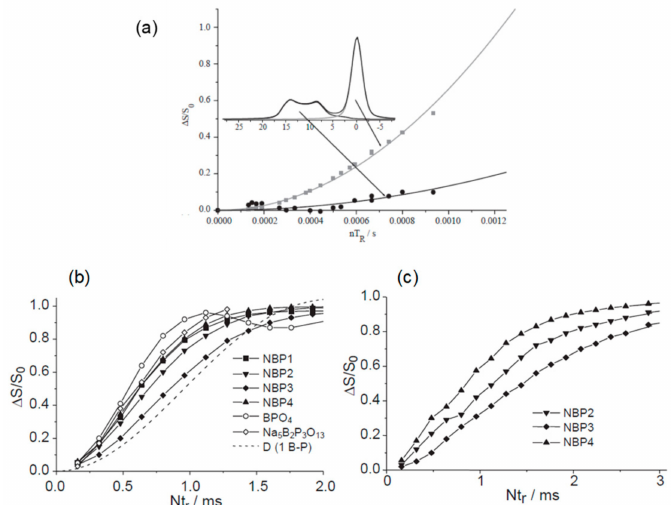
Figure 7. ( a ) 11 B( 31 P) REDOR curves obtained on [4] B and [3] B species on a Ag 2 O-B 2 O 3 -P 2 O 5 glass [25]; (b-c) 11 B( 31 P) REDOR curves observed for ( b ) [4] B and (c) [3] B on di ff erent sodium